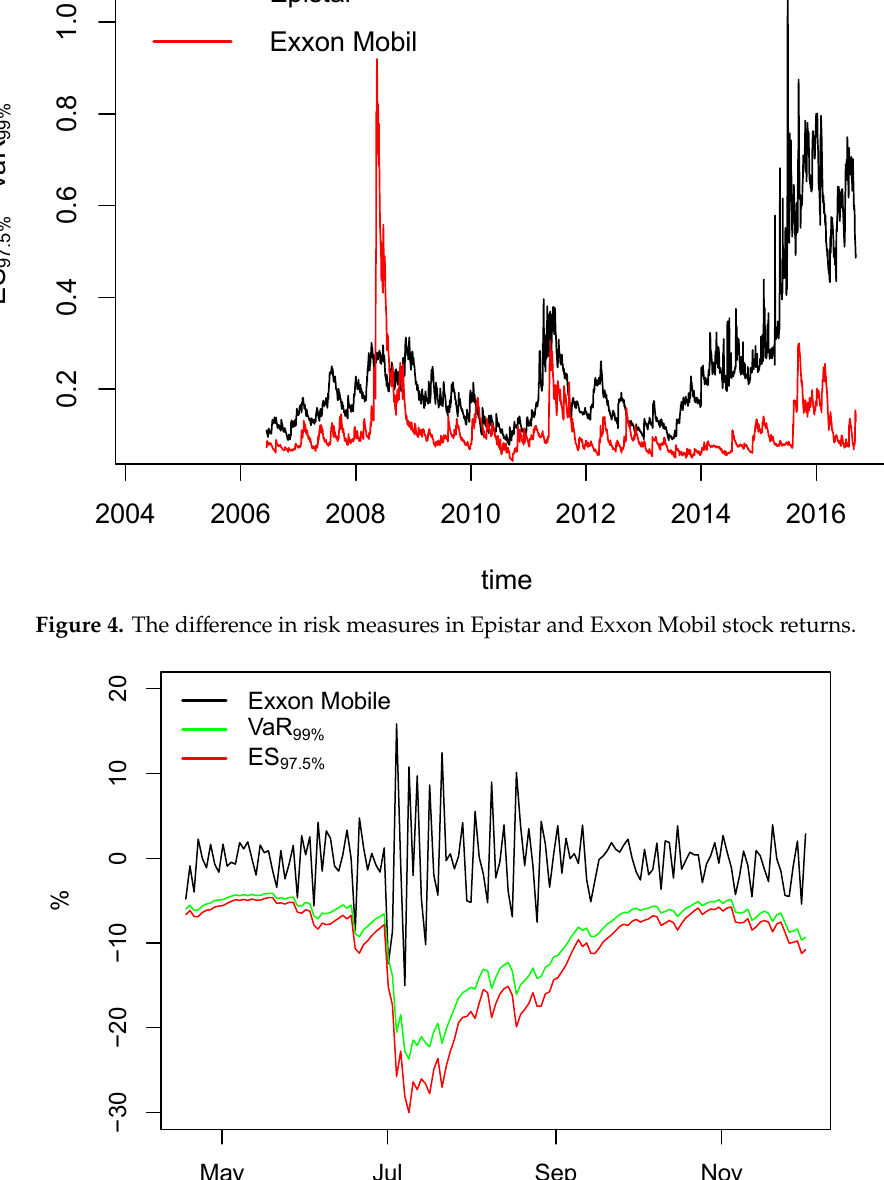
Figure 5. Estimated VaR-99% and ES-97.5% with the skewed-t distribution.